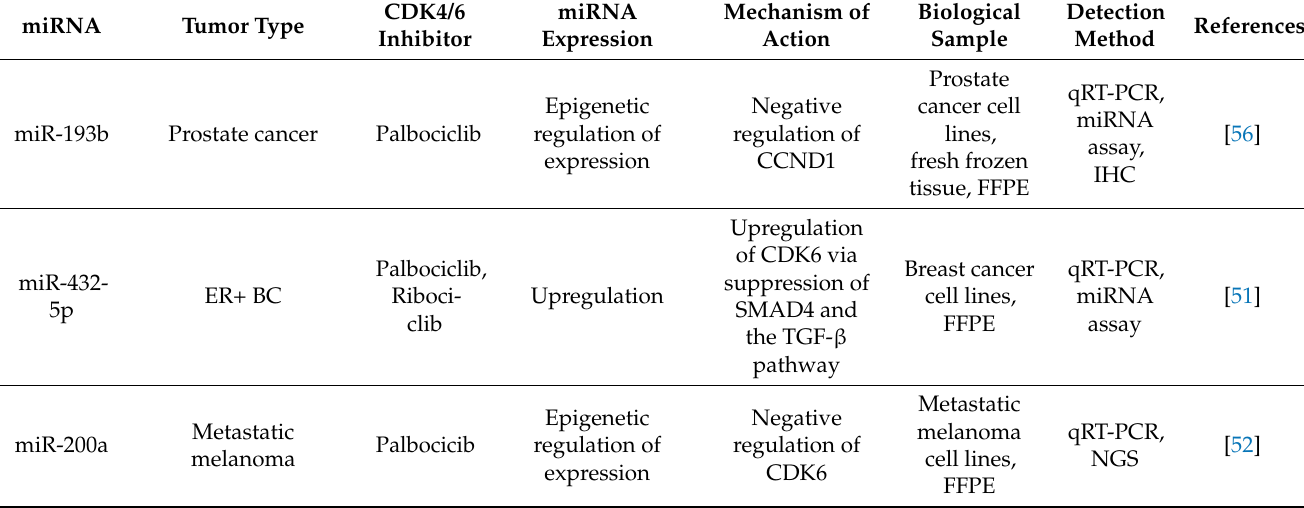
Table 2. MicroRNAs associated with resistance to CDK4/6